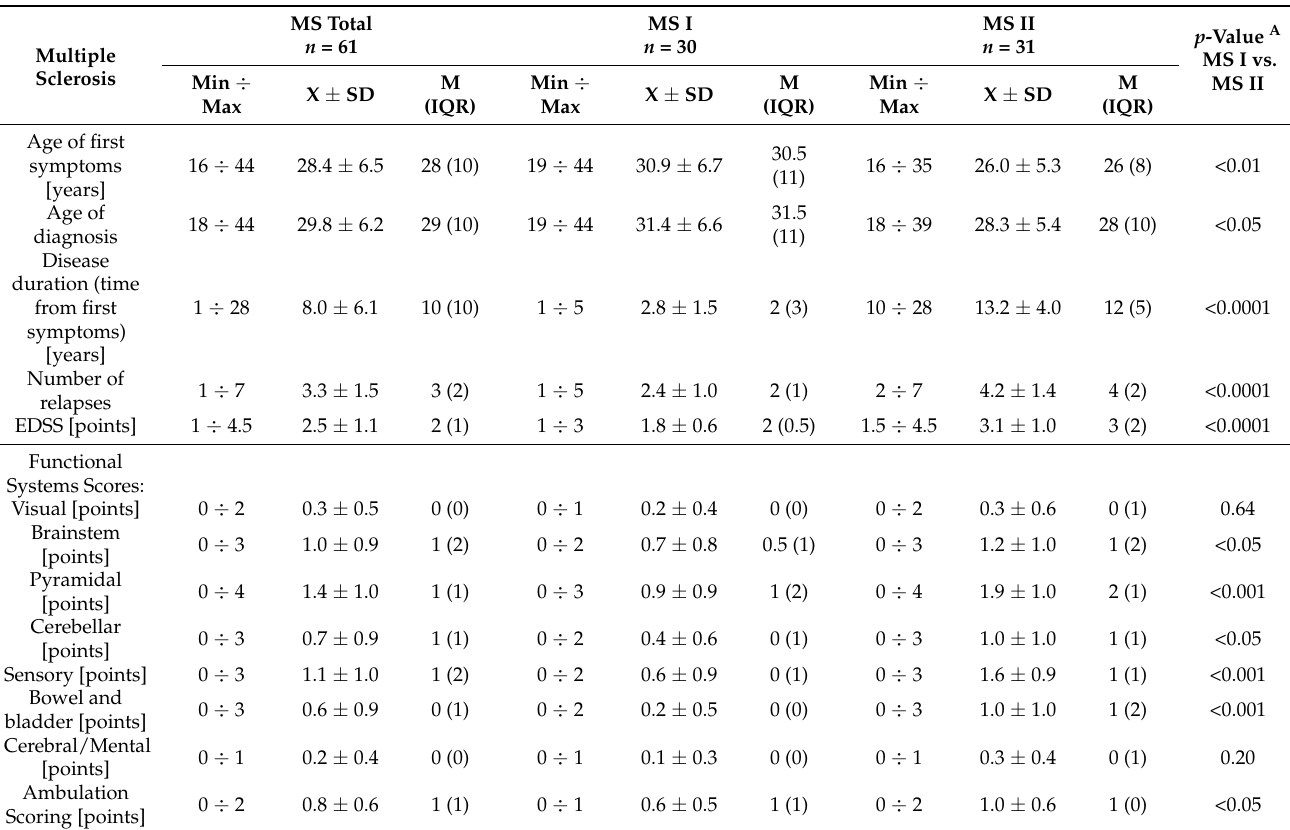
Table 2. Clinical characteristics of patients with multiple sclerosis